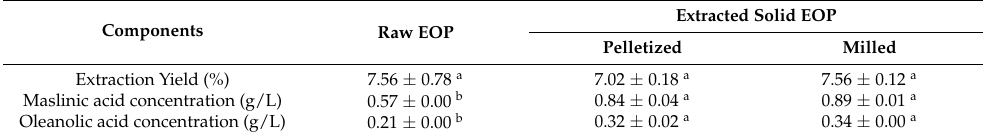
Table 7. Extraction yield and concentration of maslinic acid and oleanolic acid in the ethanolic extracts from raw exhausted olive pomace (EOP) and solids extracted from pelletized and milled EOP under optimal conditions of the ultrasound-assisted water extraction: 80% amplitude, 11.5% solid loading ( w / v ) and 16